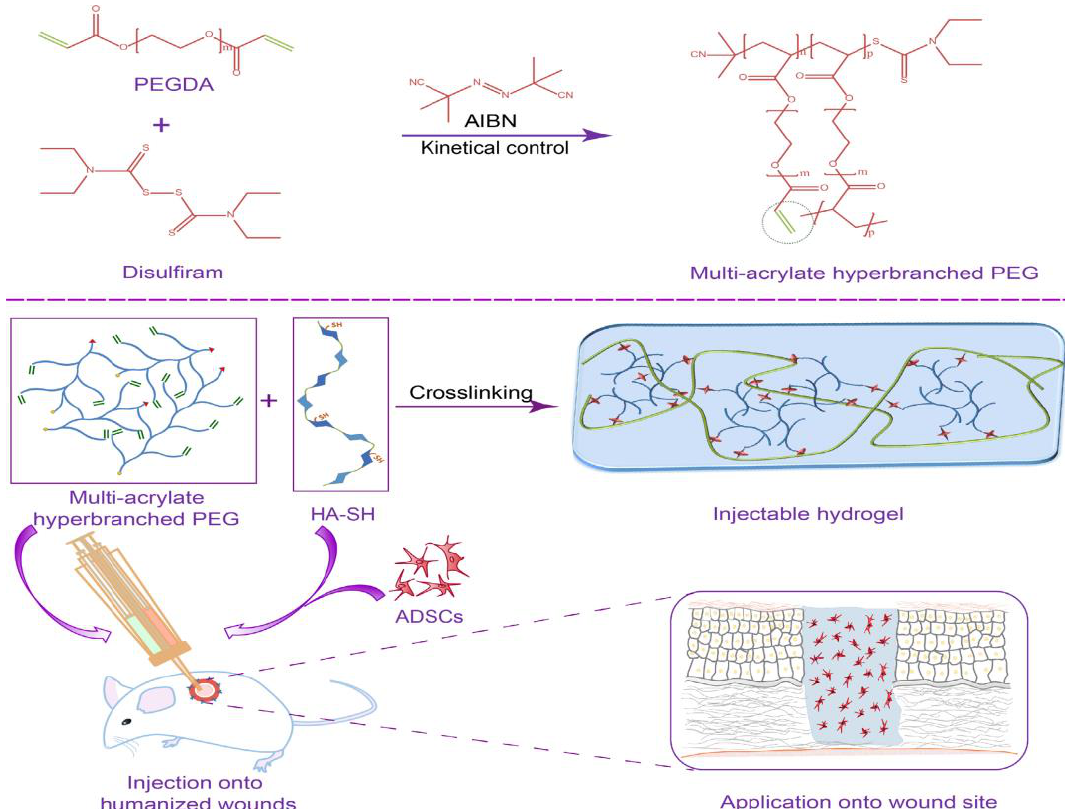
Figure 11. An overview of the concept of creating and utilizing injectable HP-PEG hydrogels. By combining AIBN and DS as initiators, in situ RAFT polymerization could be used to synthesize HP- PEG polymers. After HA-SH and HP-PEG are mixed in situ , ADSCs are embedded in the hydrogel. A humanized diabetic wound model is then used to test the hydrogel system [205]. Table 4. A summary of recent advances in wound dressings based on polymer-based nanostructures. Polymer-Based